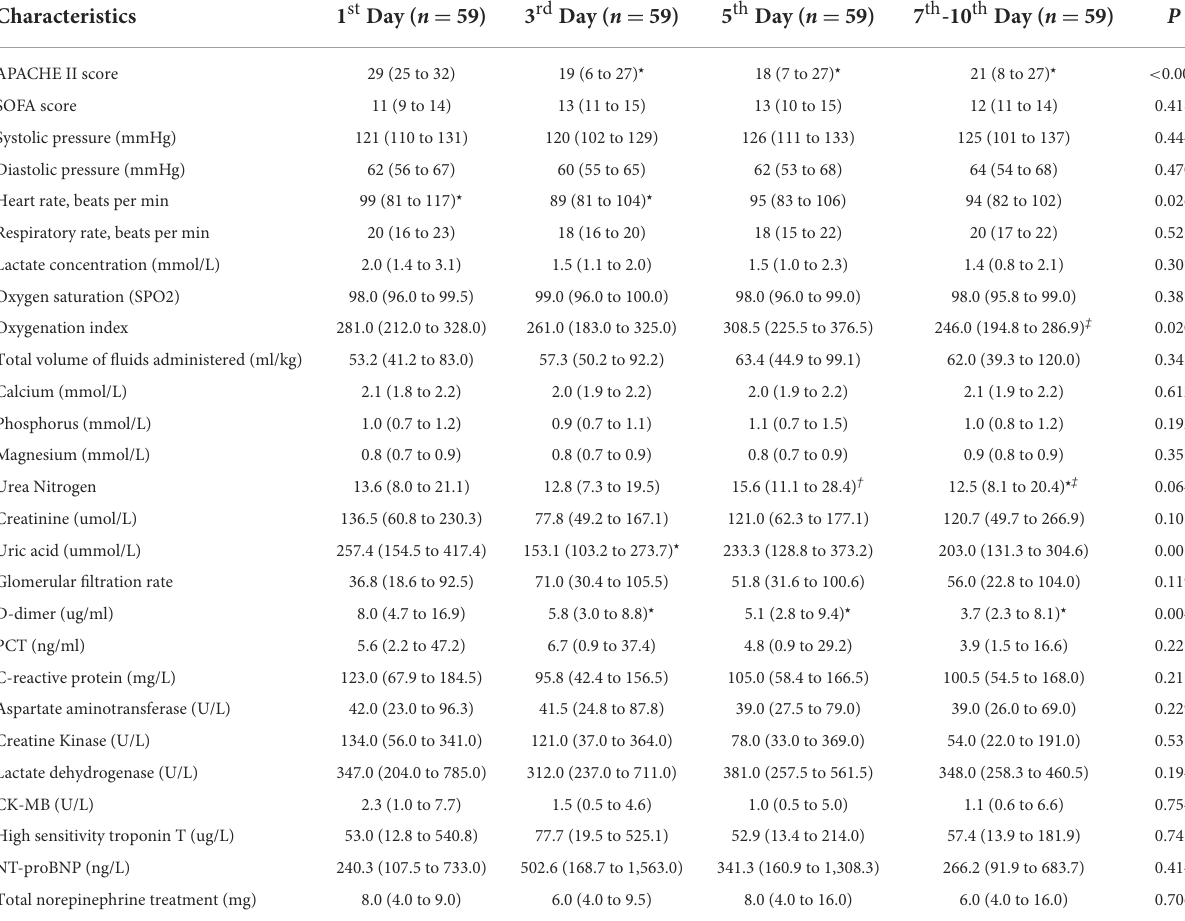
TABLE 2 Intensive care measurements and vital signs over time in patients.